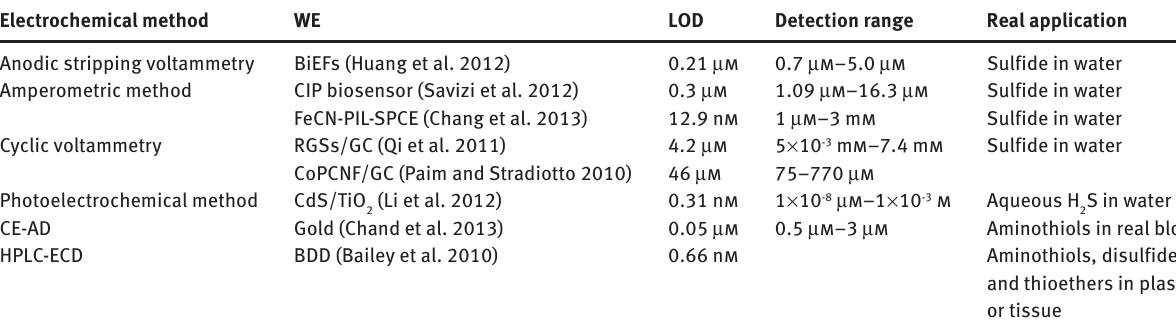
Table 2 Different analytical characteristics by different electrochemical methods. Electrochemical method